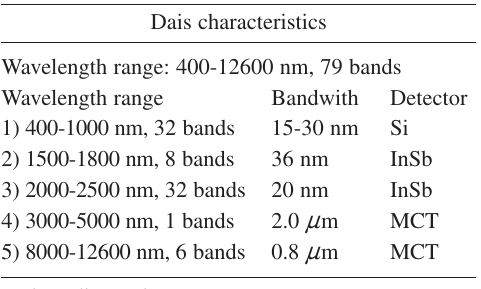
Table I. Main features of the DAIS sensor. Dais characteristics